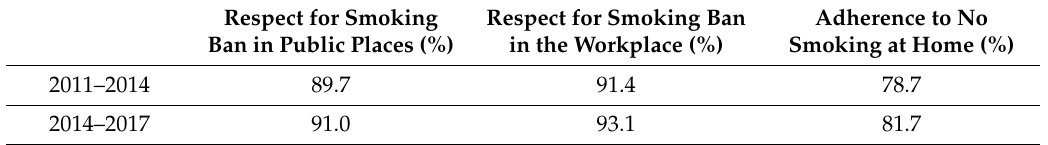
Table 1. Rate of adherence to smoking ban in public places, workplaces and no smoking at home. Respect for Smoking Respect for Smoking Ban Adherence to No Ban in Public Places (%) in the Workplace (%)